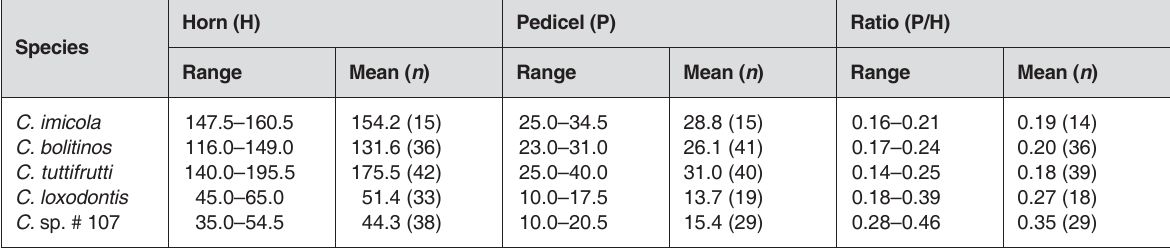
TABLE 1 Respiratory organ, pedicel lengths ( μ m) and P/H ratios of five species of Culicoides of the Imicola complex